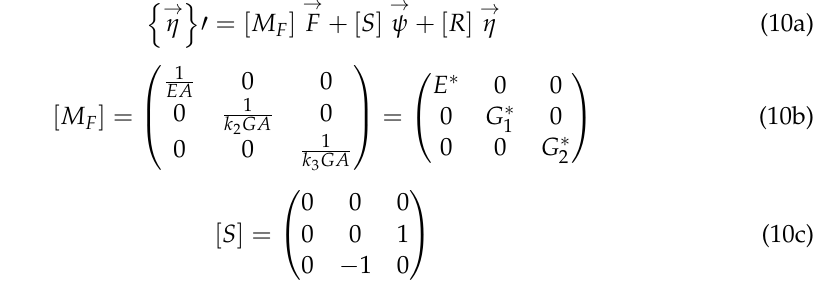
along the normal axis, and I ∗